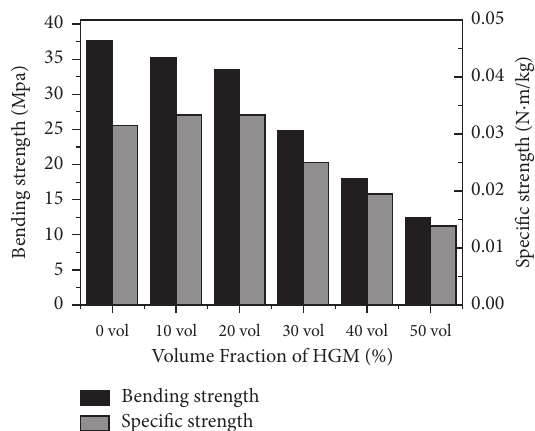
Figure 5: Flexural strength and specific strength of HGM/phenolic syntactic foam.